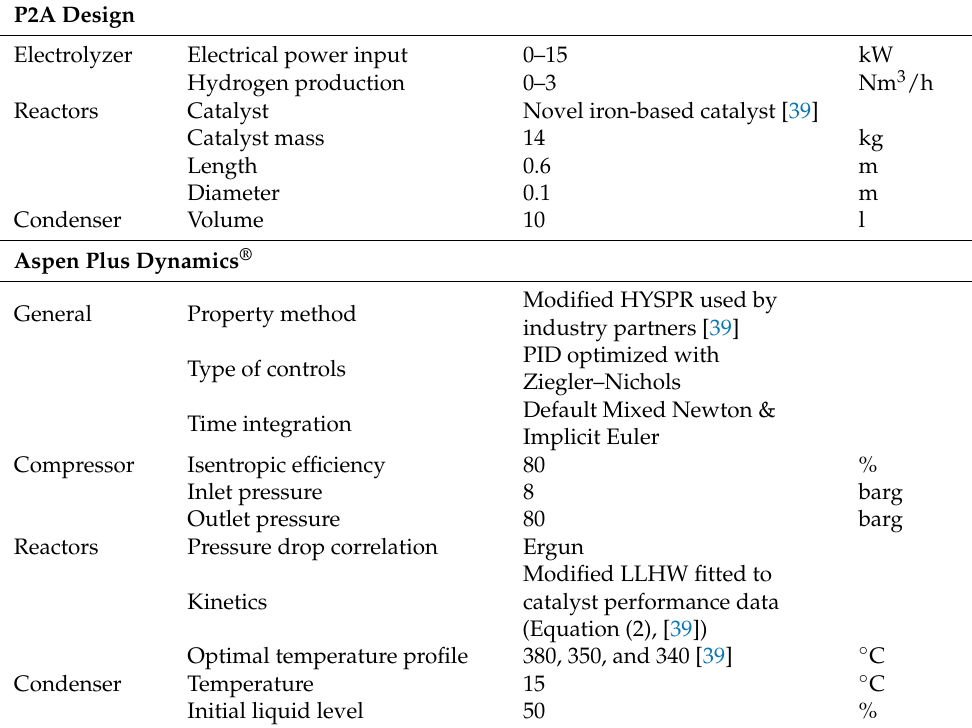
Table 2 . Main parameters of the novel P2A design and its implementation in Aspen Plus Dynamics ® .